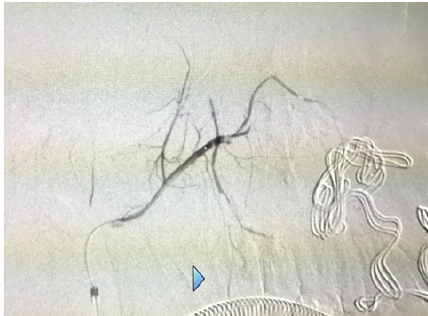
Figure 3: A microcatheter (EV3 Marathon) was navigated coaxially into the parent artery over a guidewire (EV3 Silver Speed) to reach the